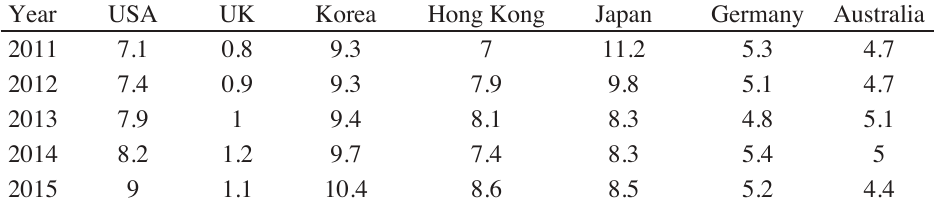
Imports of China from Major Trading Countries